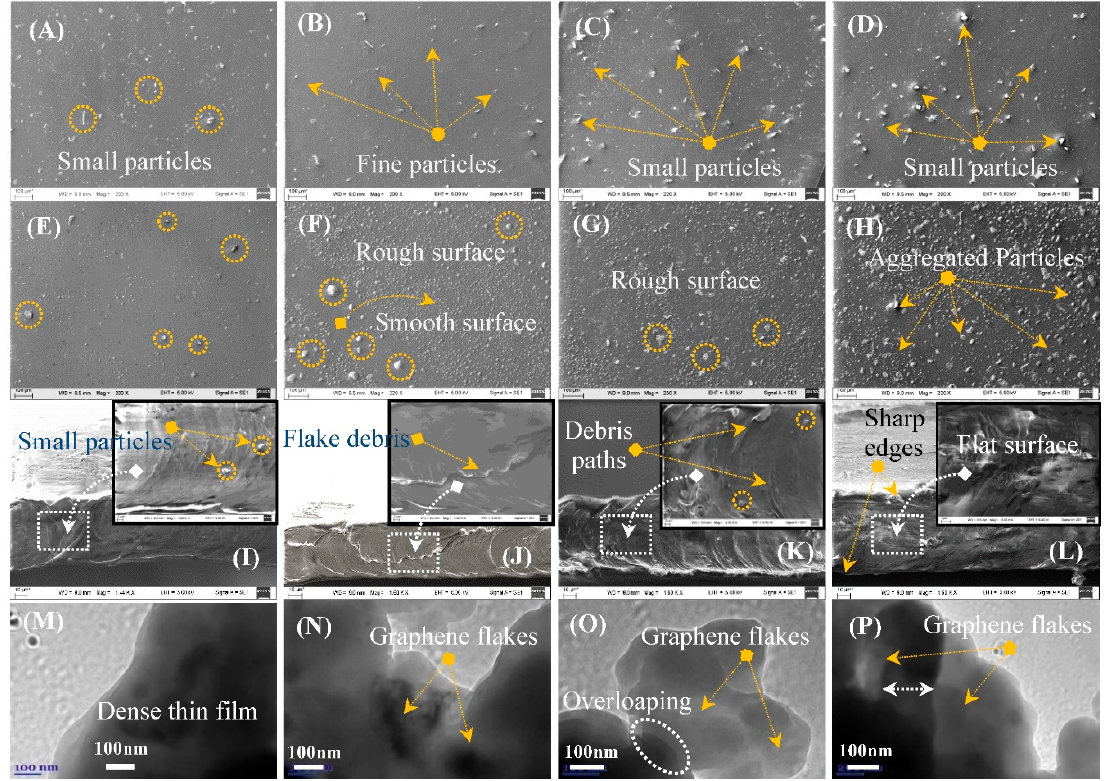
Figure 5. (A – L ) SEM images and ( M – P ) TEM images. Figure 5. ( A – L ) SEM images and ( M – P ) TEM